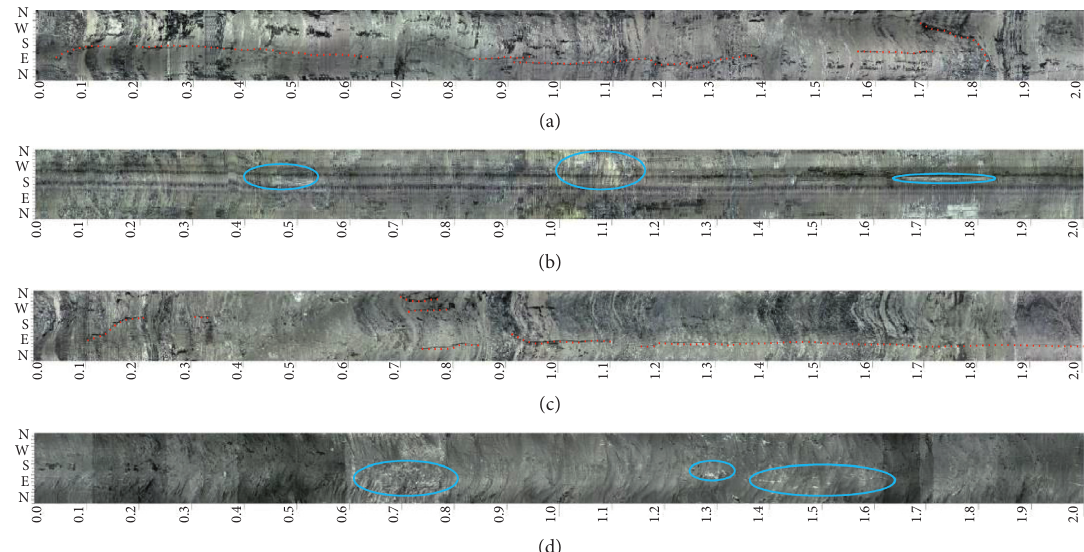
Figure 9: Borehole observation picture of the surrounding rock before and after the grouting process: (a) 0 ∼ 2m-before grouting; (b) 0 ∼ 2m- after grouting; (c) 2 ∼ 4m-before grouting; and (d) 2 ∼ 4m-after grouting.